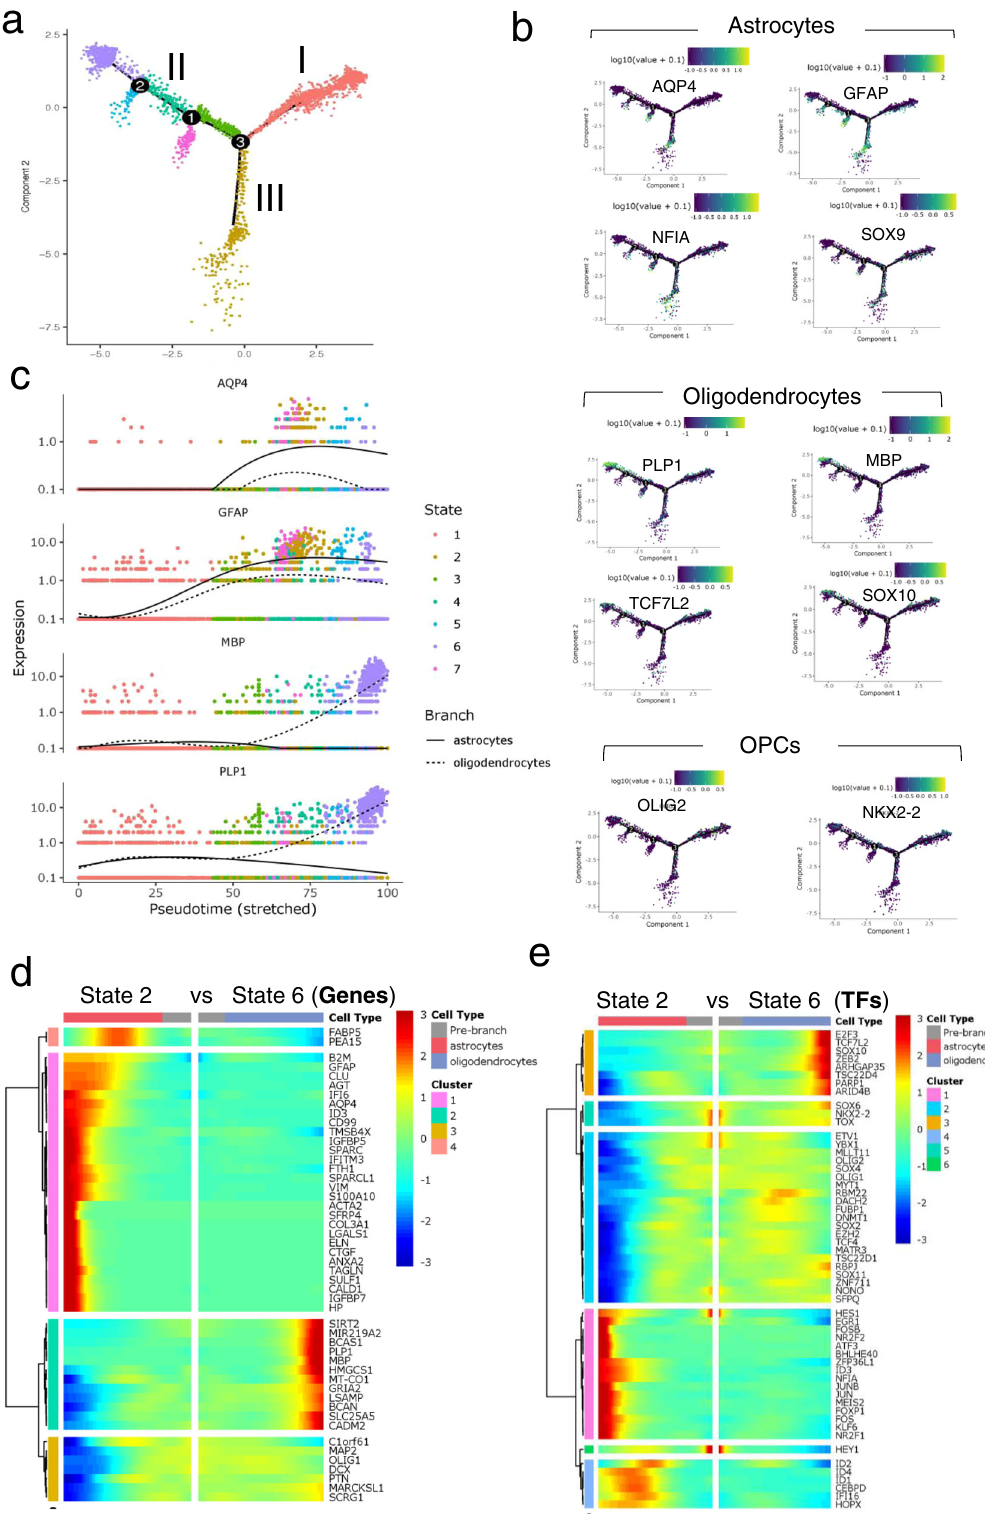
1q and 20q as they get to higher passage number. We also observed isochromosome duplication of chromosome 1q as early as passage 10, ~3 months after generation